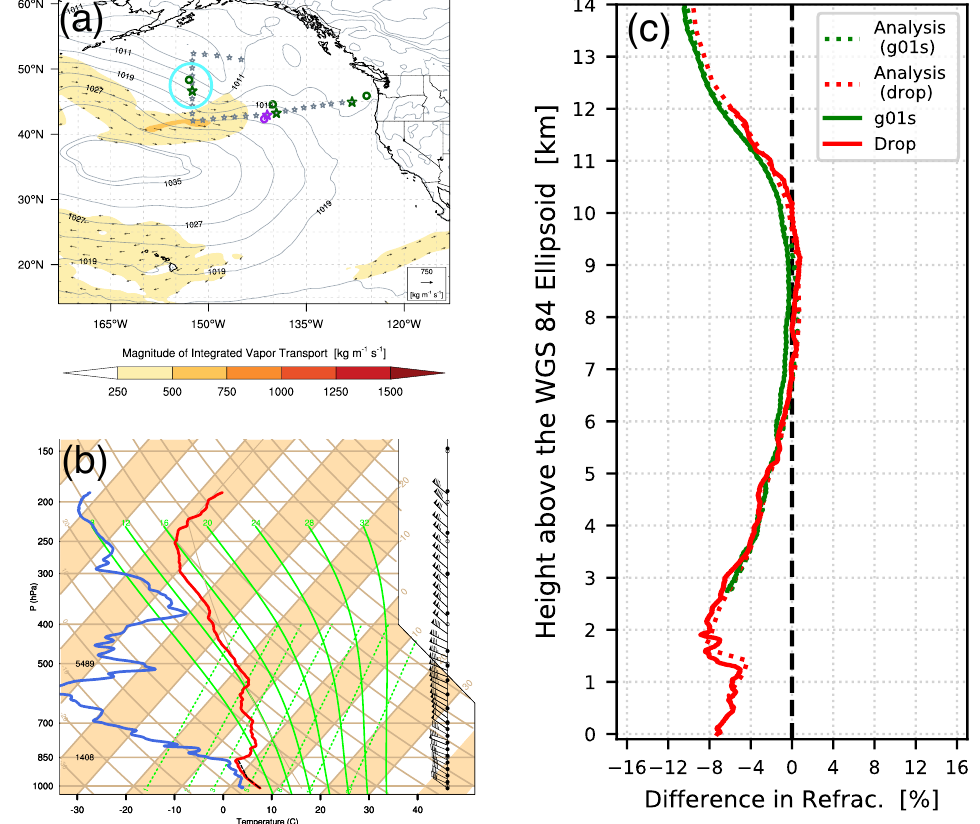
Figure 1. An example occultation from the operational dataset (MetOp-C mission) that was just under 200 km apart in space and just under 2 h apart in time. ( a ) Overview of the thirteenth intensive observing period (IOP13) of AR Recon 2020 with integrated vapor transport (kg m − 1 s − 1 , shaded and vectors) and mean sea level pressure (hPa, grey contours) shown. The locations of dropsondes are indicated by grey stars and occultations from the operational, and COSMIC-2 datasets are indicated by green, and purple circles, respectively, with each of their collocated dropsondes indicated by enlarged stars of the same color. The location of the occultation/dropsonde pair highlighted for this example is circled in light blue. ( b ) A standard Skew-T Log P diagram of the data collected by the dropsonde in the example pair with the dry bulb temperature indicated by the red curve and dew point temperature indicated by the blue curve. ( c ) The difference in refractivity (% N) between a zonal climatology during February at 27 ◦ N and the example occultation (solid green line), its nearest dropsonde (solid red line), and their corresponding reanalysis profiles (dotted lines of the same color as their